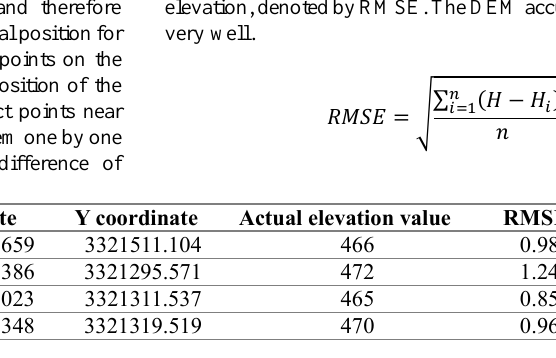
Table 2. DEM accuracy